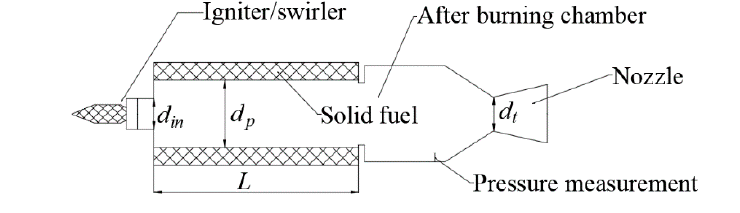
Figure 2. The experimental system.